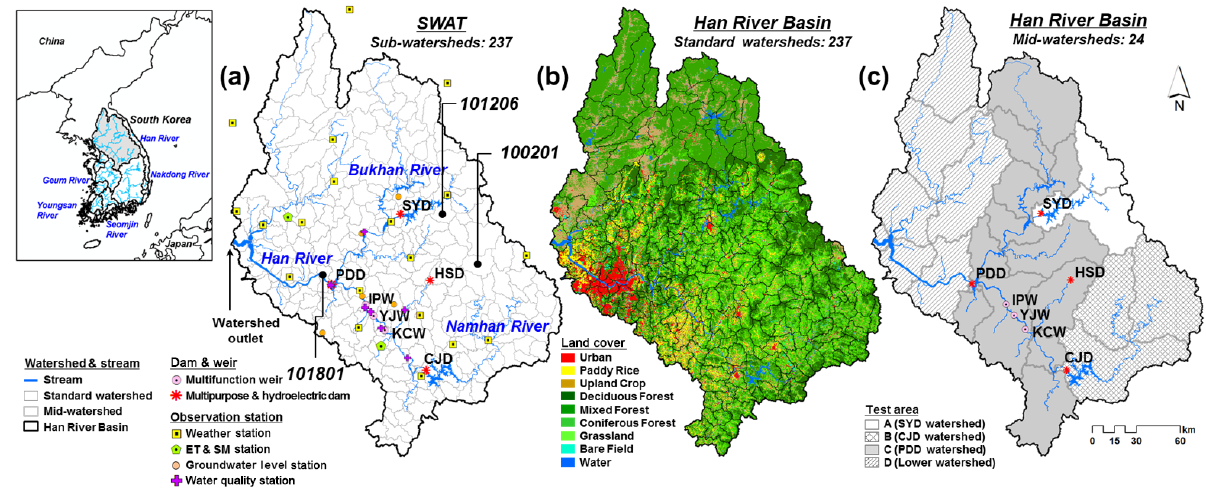
Figure 2. Locations of the (a) Han River basin’s boundaries and gauging stations for the watershed (SWAT) modeling, (b) land-cover classification, and (c) test